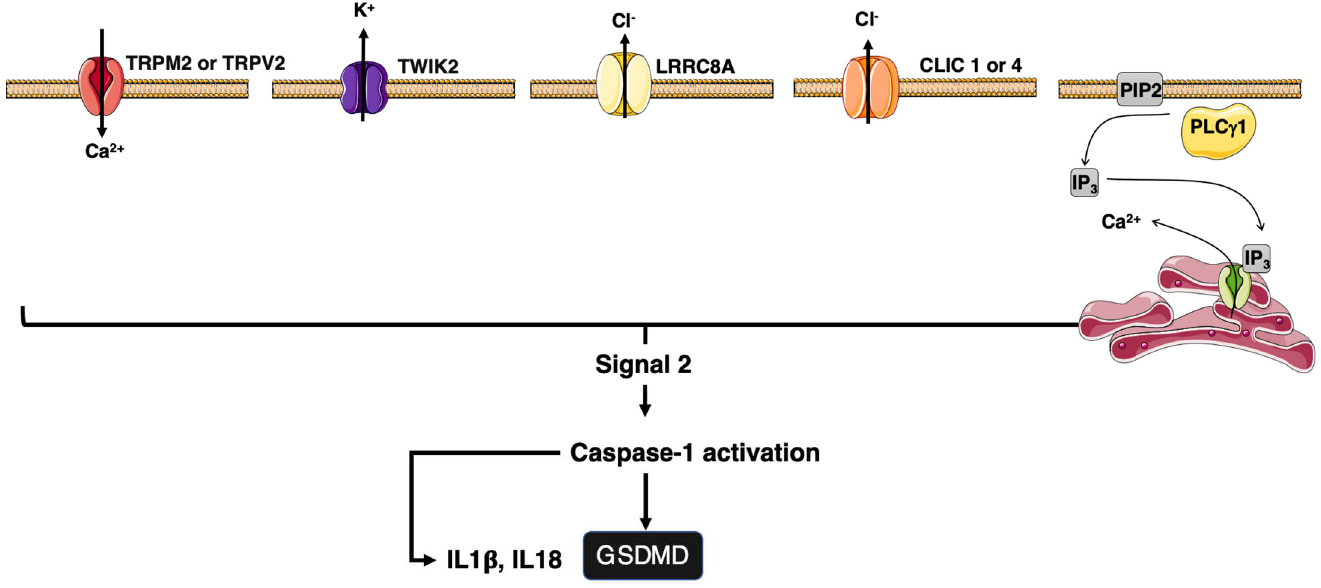
Figure 2. Representation of ion channels involved in the inflammasome activation. Different plasma membrane or endoplasmic reticulum ion channels have been involved in ion fluxes ( black arrows ) responsible for the signal 2 activating the inflammasome.